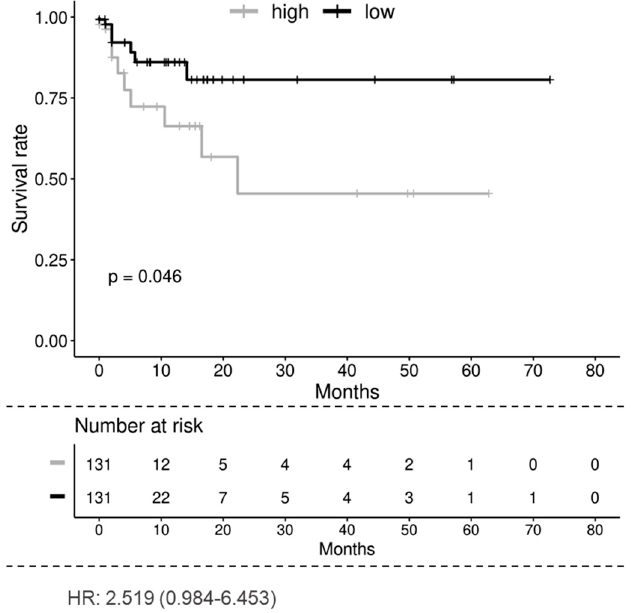
Figure 7. Overall survival of patients with low and high CYTSA expression. Kaplan–Meier analysis of the TCGA colorectal adenocarcinoma data set shows that the low CYTSA gene expression group (below median expression, N = 131, black curve) is associated with significantly better survival than the high CYTSA expression group (above median expression, N = 131, gray curve). p < 0.05. Numbers of patients at risk at various time points and the hazard ratio are shown.